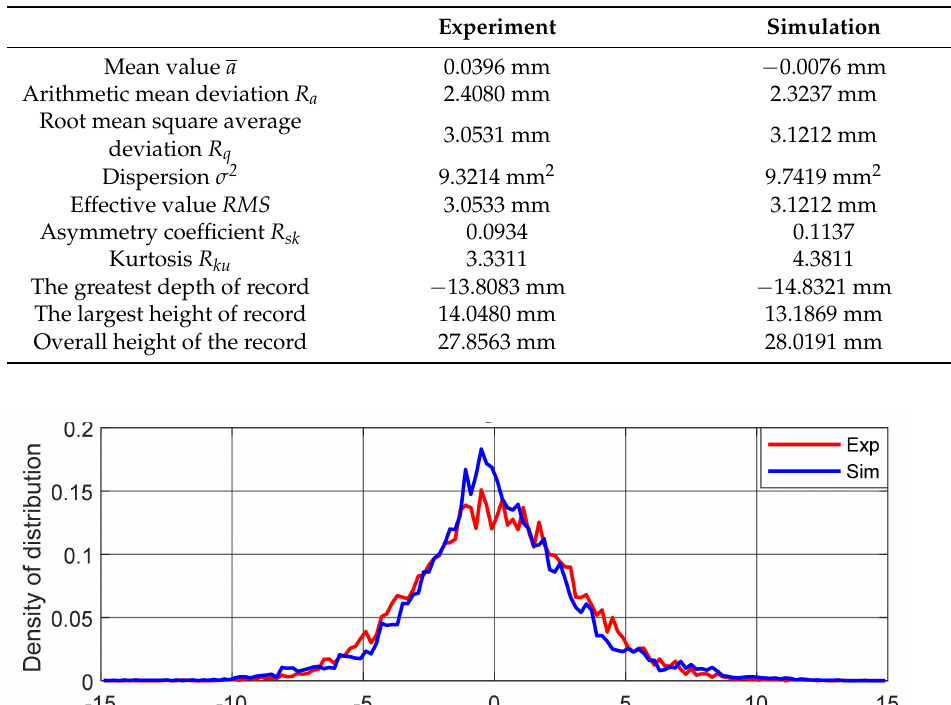
Table 6. Statistical characteristics of acceleration on vehicle FA.